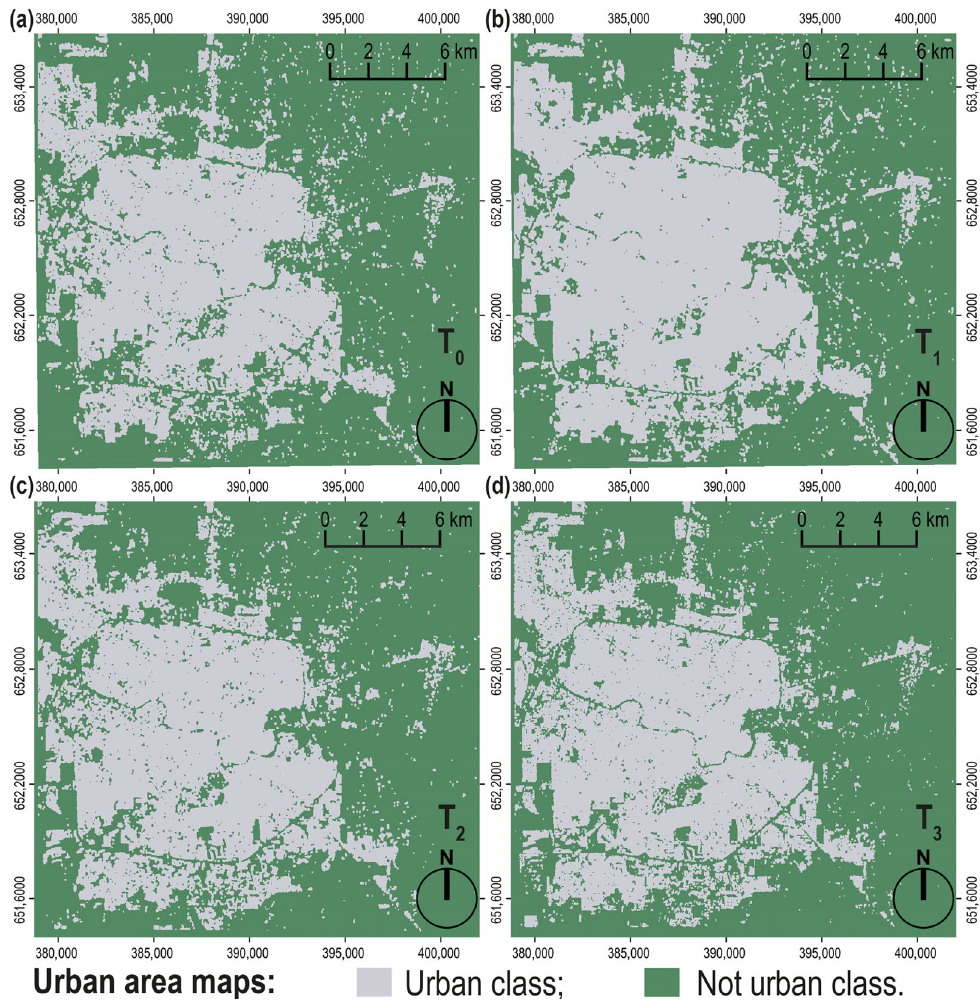
Figure 3. Urban area extent maps (reference system: WGS84 UTM20 S, EPSG code: 32720) obtained by applying the UEXT algorithm to CSK data at T 0 ( a ), T 1 ( b ), T 2 ( c ), and T 3 ( d Table 2. Accuracy assessment of urban area extent maps obtained by applying UEXT to CSK data at T 0 , T 1 , T 2 and T 3 .